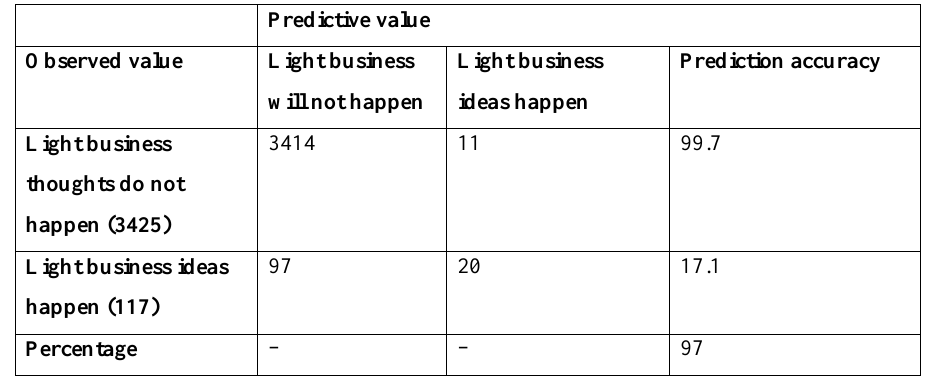
Table 3 Classification matrix and probability of undergraduates’ depressive symptoms for predicting light business